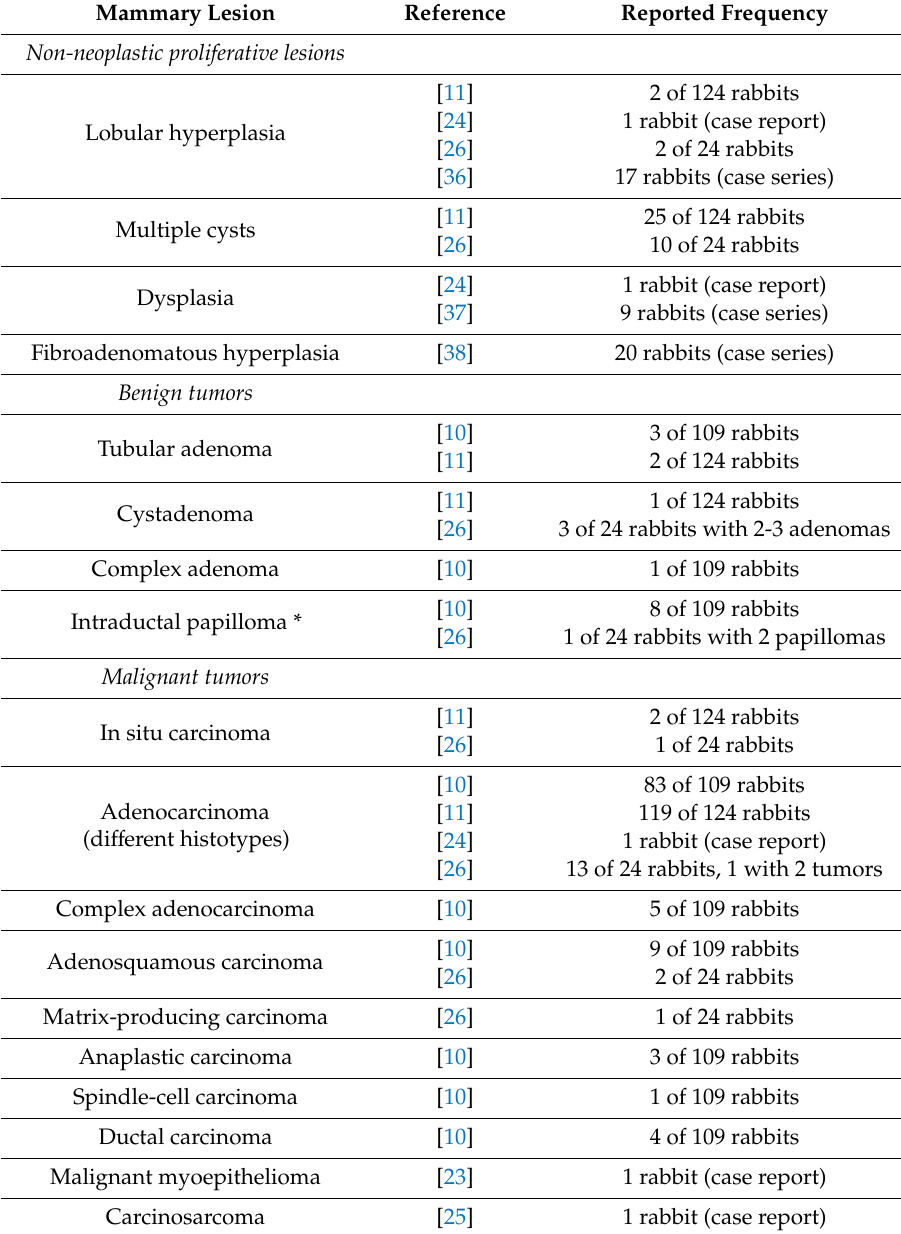
Table 1. Non-neoplastic proliferative and neoplastic mammary gland lesions in pet rabbits. Mammary